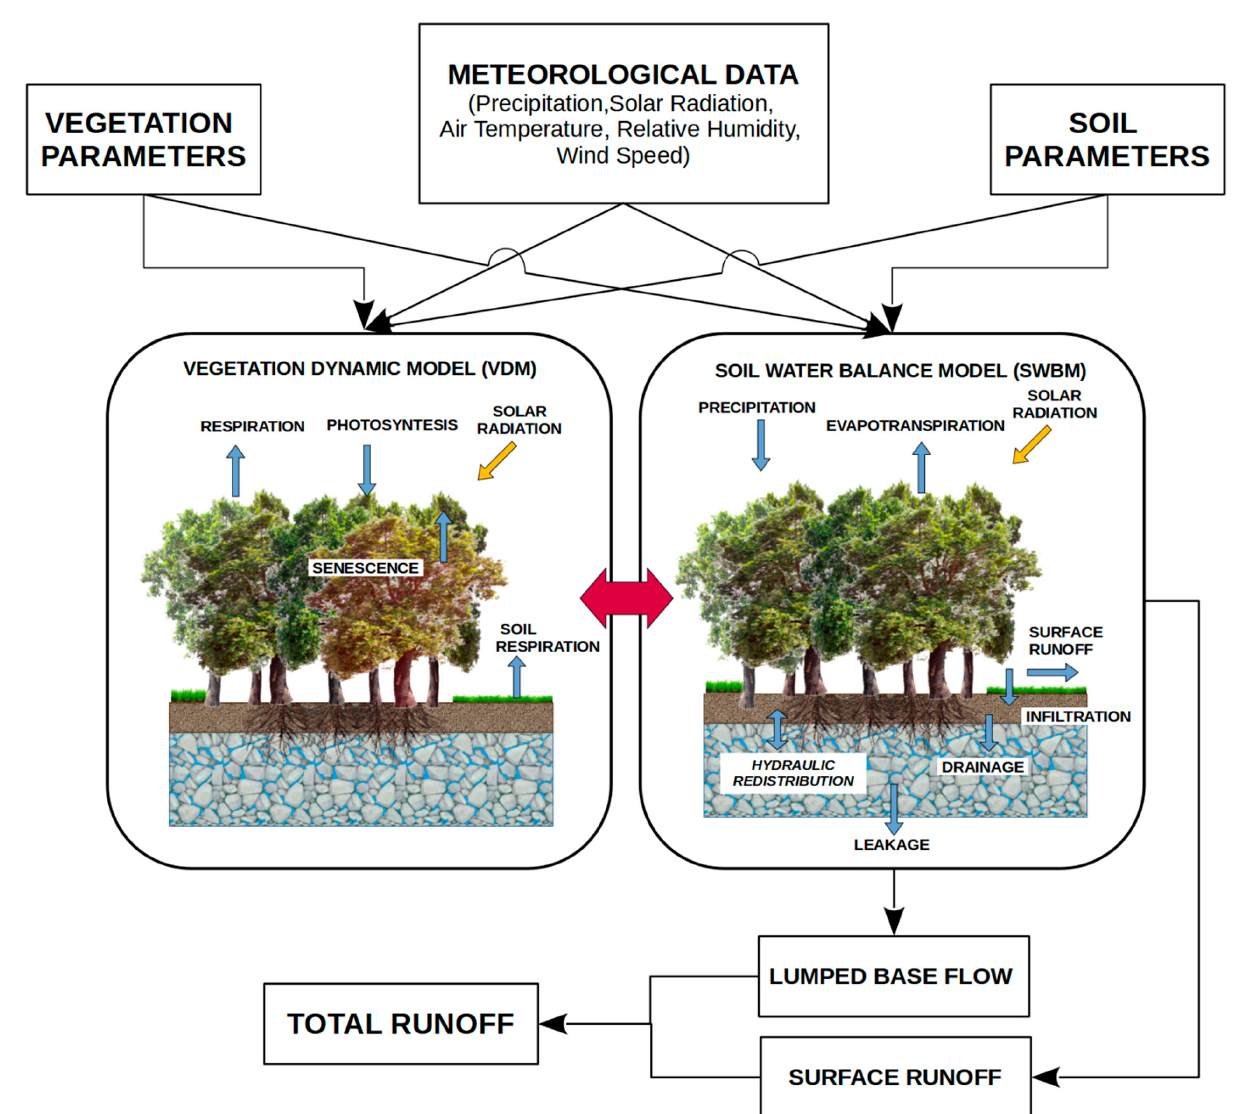
Figure 3. Model structure of the distributed ecohydrological model. Table 1. Model parameters of the vegetation components.